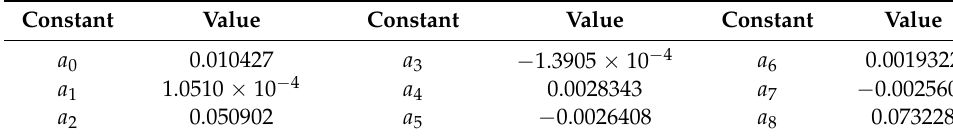
. m polymer = f ( N , p ) .